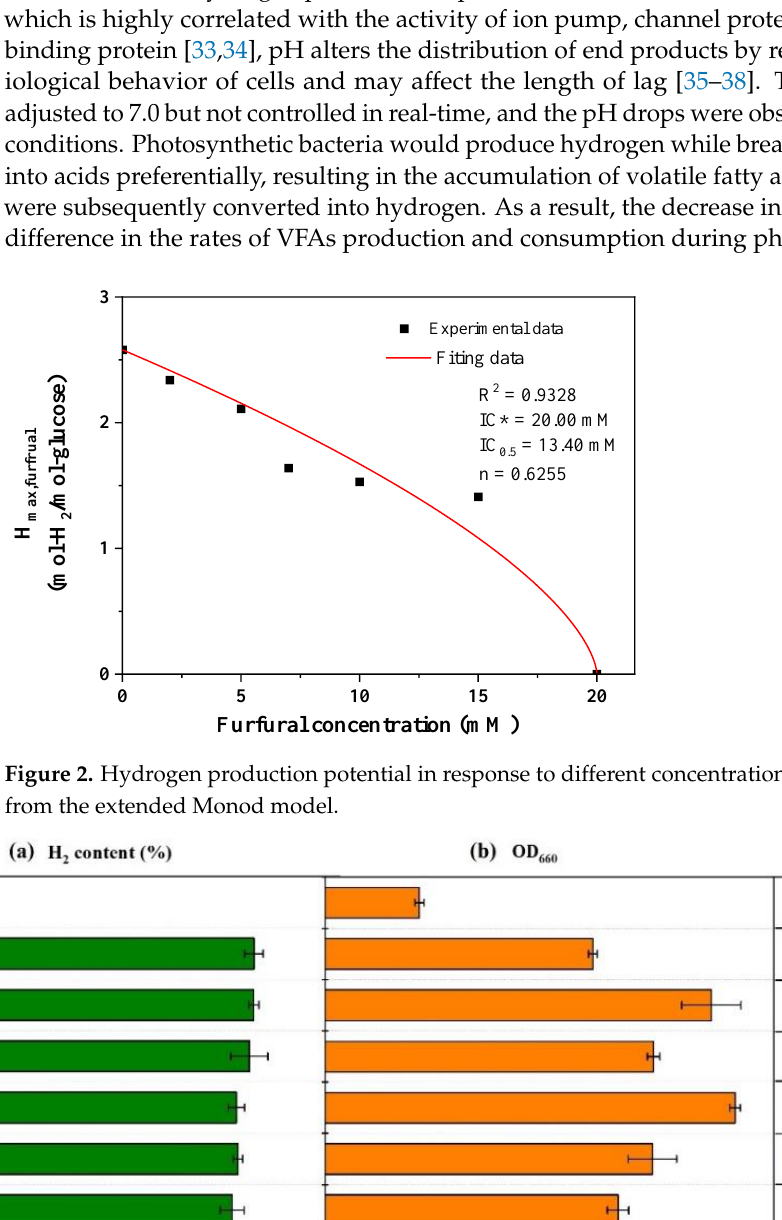
Figure 2. Hydrogen production potential in response to different concentrations of furfural derived from the extended Monod model.